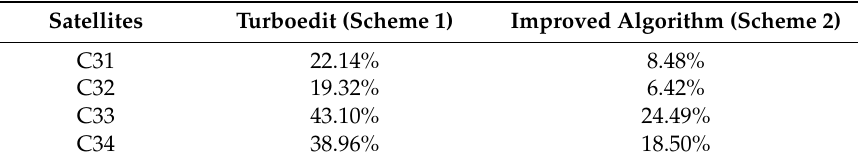
Table 8. The percentage of eliminated data based on BDS-3 orbit